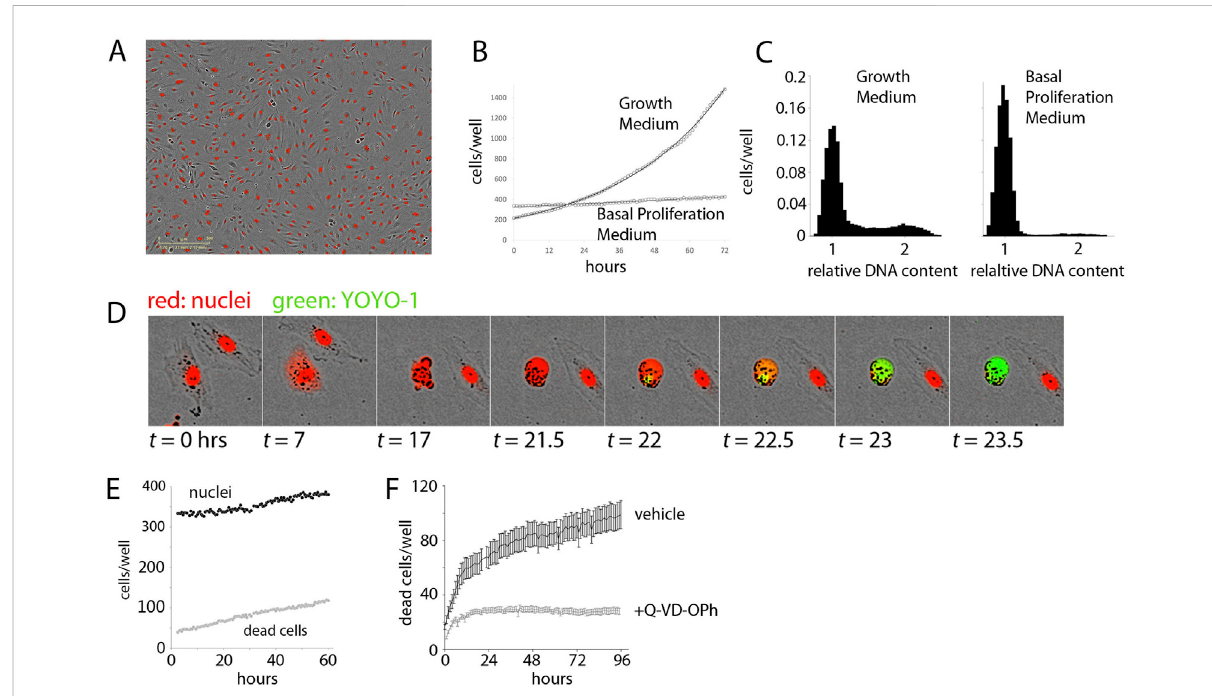
FIGURE 1 Establishment of the Experimental System. (A) . Demonstration of Dermal Microvascular Endothelial Cell (DMEC) labeling. Fluorescent image of nuclear-localized mCherry overlaid on a phase contrast image of con fl uent DMECs. (B) . The proliferation of DMECs in full growth medium (dotted line) is exponential (solid line is a fi tted exponential curve). (C) . Cell cycle analysis of relative DNA content determined by labeling live cells with Hoescht and imaged with a microscope. Full growth medium (left) produces a familiar distribution of cells while 24 h in Basal Proliferation Medium(BPM)(right)producesfarfewercellsinS-andG2/M-phases. (D) .DemonstrationofYOYO-1dyetodetectdeadcells. (E) .)Exampleofnuclei (closed circles) and dead cells (open circles) over time in BPM. (F) . Cell death in BPM is countered by inhibition of caspase activity via 10 µM